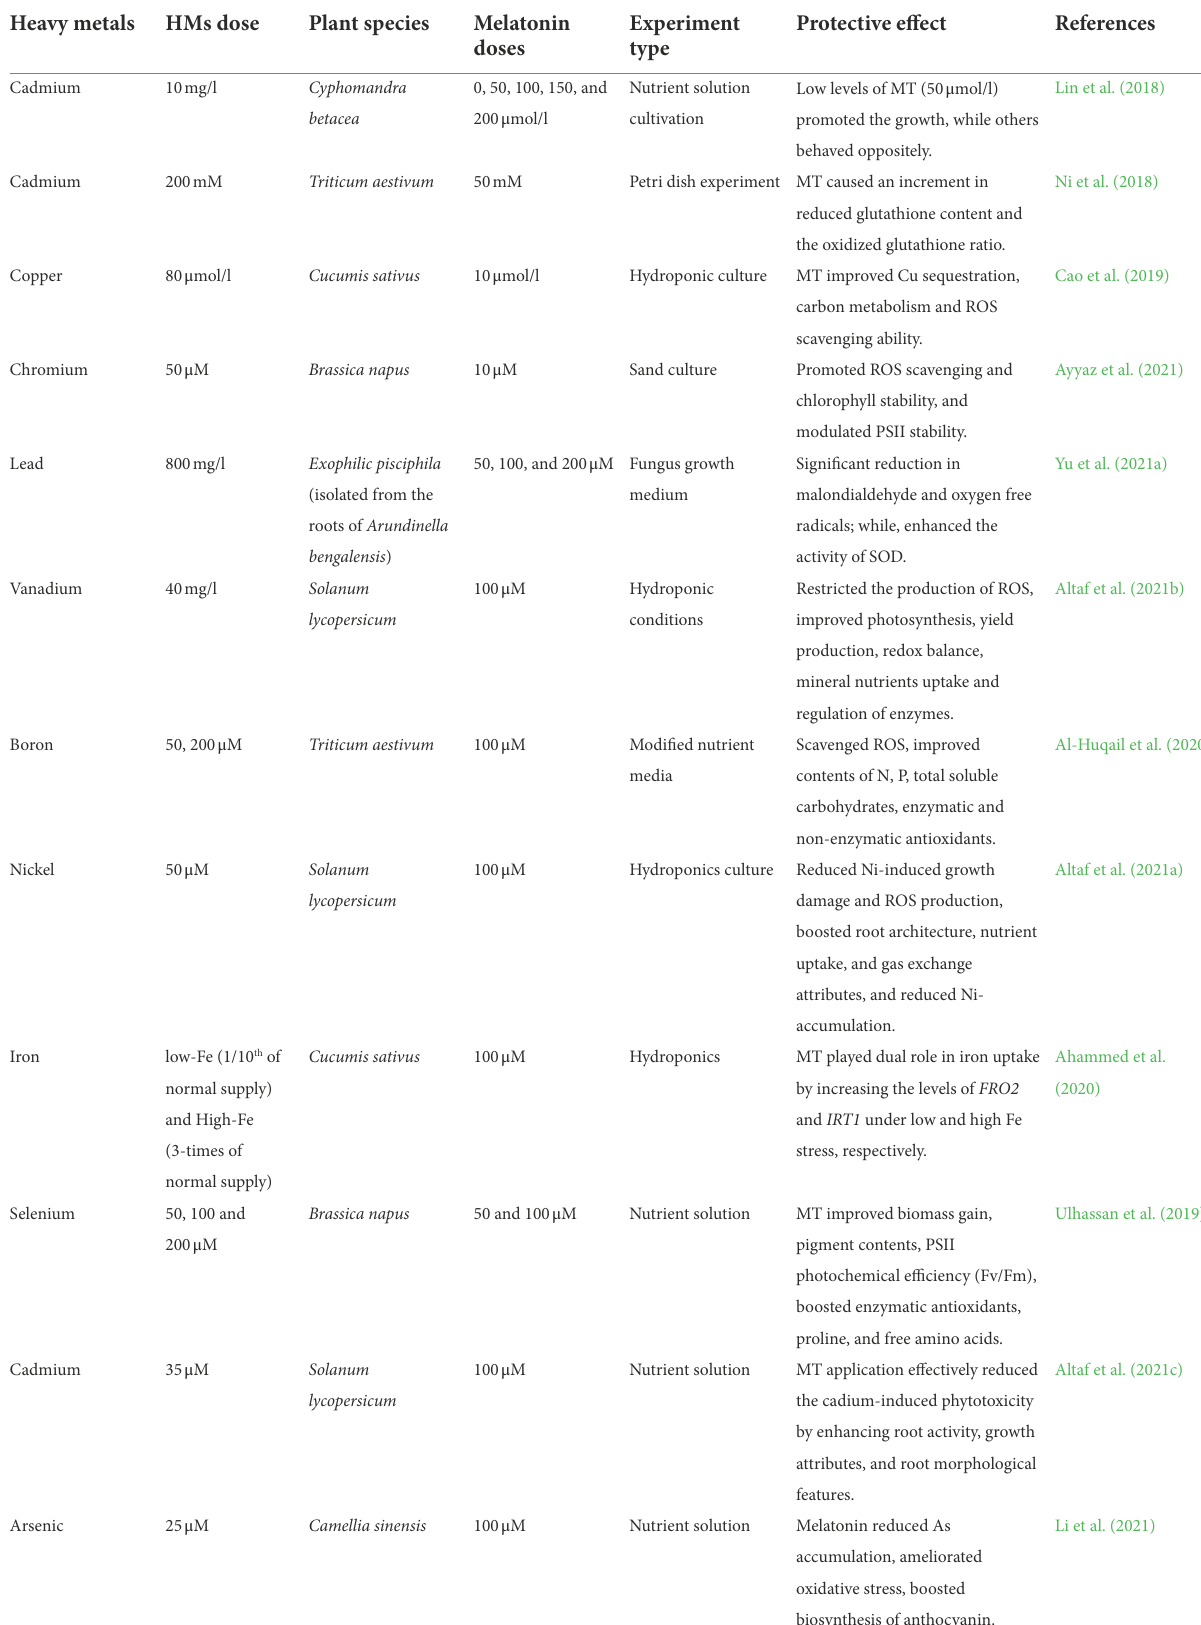
TABLE 1 Ameliorative effects of MT supplementation on growth, physiological, and biochemical attributes of plants grown under heavy metals